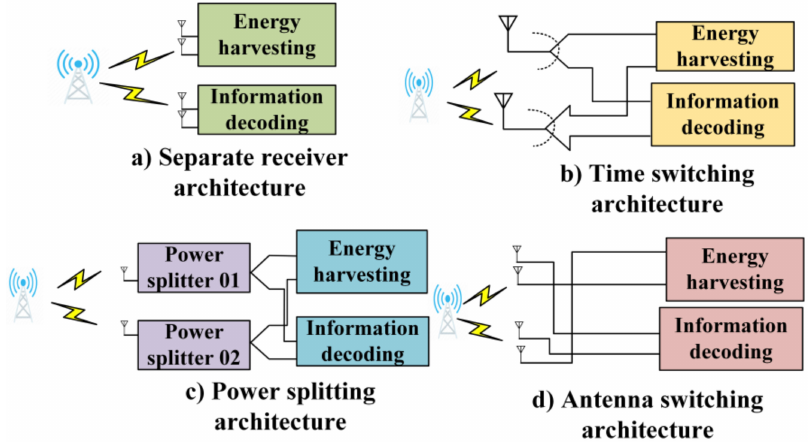
Figure 6. Receiver architecture designs for SWIPT: ( a ) separate receiver architecture with separate receiver for energy and information decoding, ( b ) time switching architecture where time is allocated to the particular antenna for energy harvesting and information decoding, ( c ) power splitting archi- tecture where the power splitting receiver divides the signal into two streams of power depending on power splitting ratio, and ( d ) antenna switching receiver that switches between antennas for energy harvesting and information decoding based on the optimization